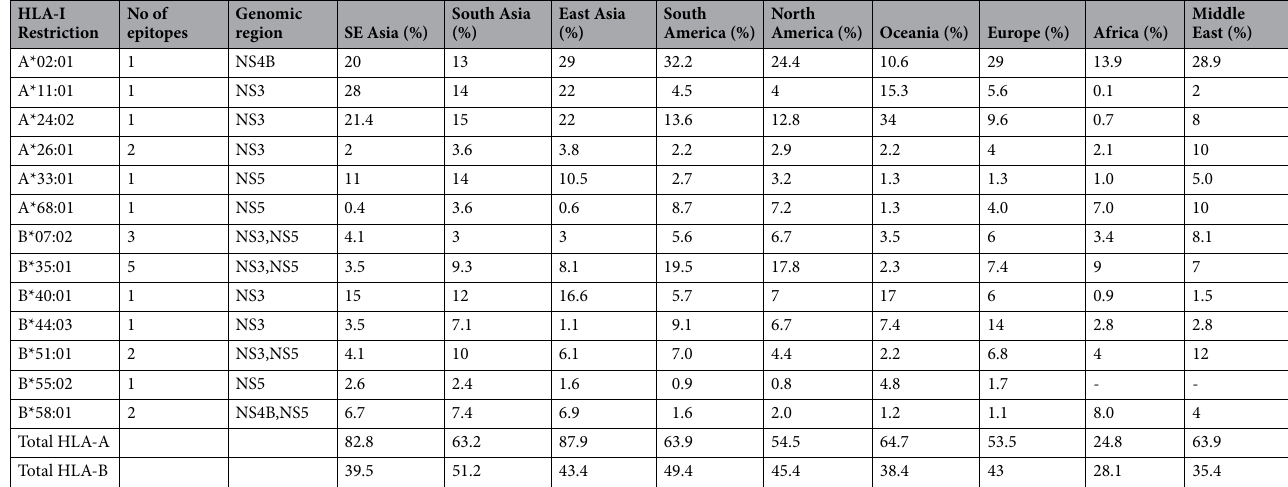
Table 3. Population coverage of the HLA restrictions identified from the conserved